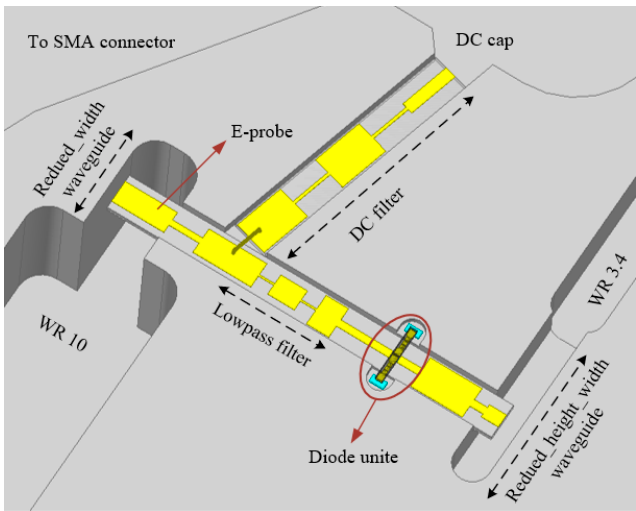
Figure 2. Overall three ‐ dimensional electromagnetic frequency tripler model.